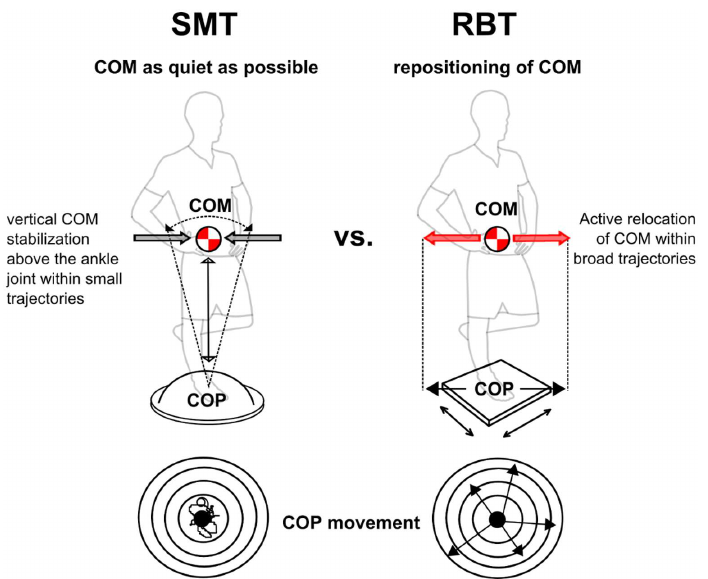
Fig 1. Biomechanical characteristics of the two selected balance trainings: the sensorimotor training (SMT, left) and reactivebalance training (RBT, right) intervention. DuringSMT, the center of mass (COM) needs to be kept as still as possibleand stability is reachedwhen the COM stays solidlywith the body as an inverted pendulumrotating aroundthe ankle joint. During RBT, after each perturbationof the support surface, the COM needsto be actively relocated through the proximalsegment to keep a stable